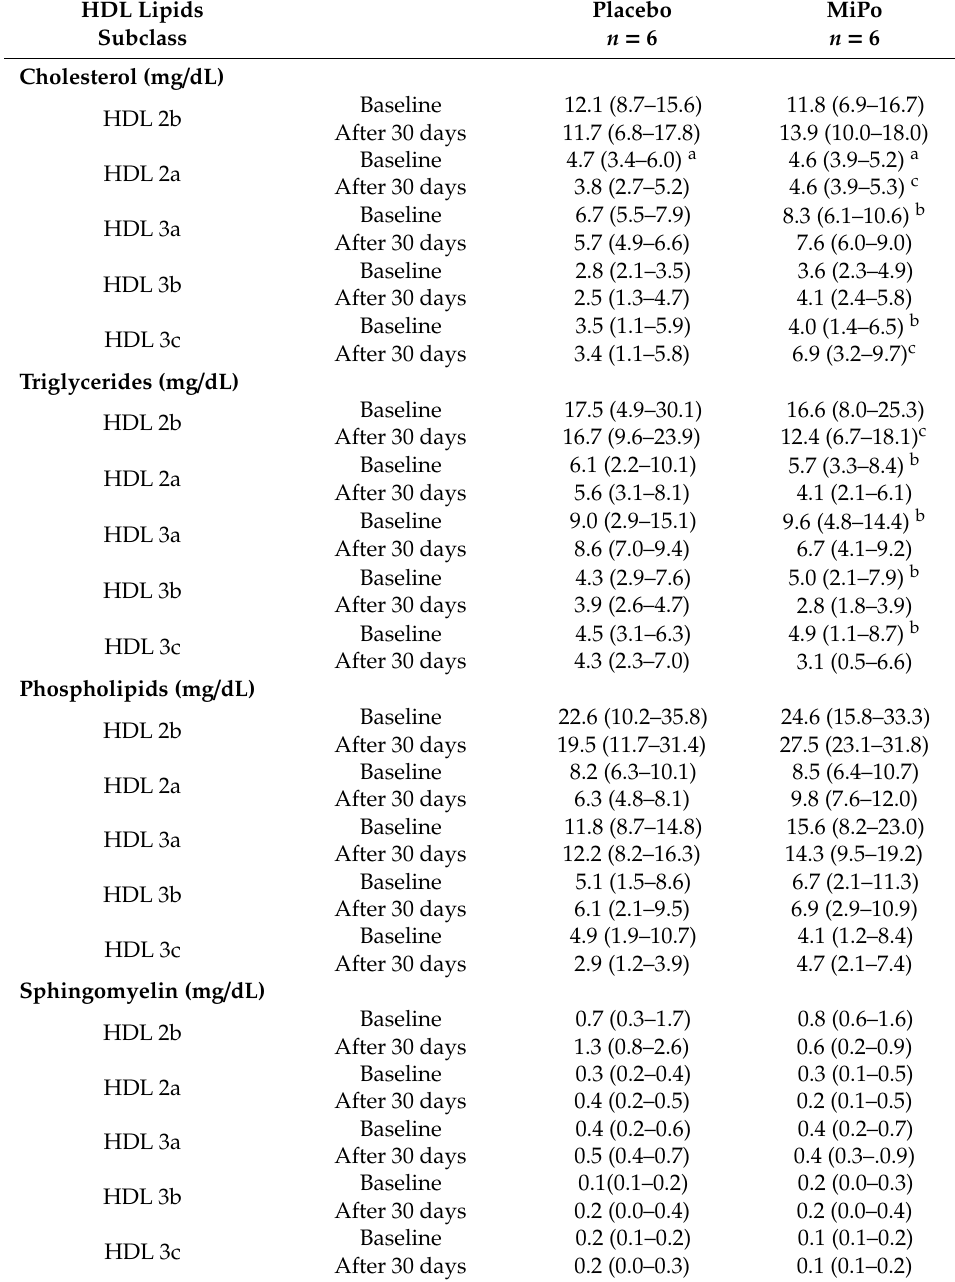
Table 2. Lipid composition of high-density lipoproteins (HDL)